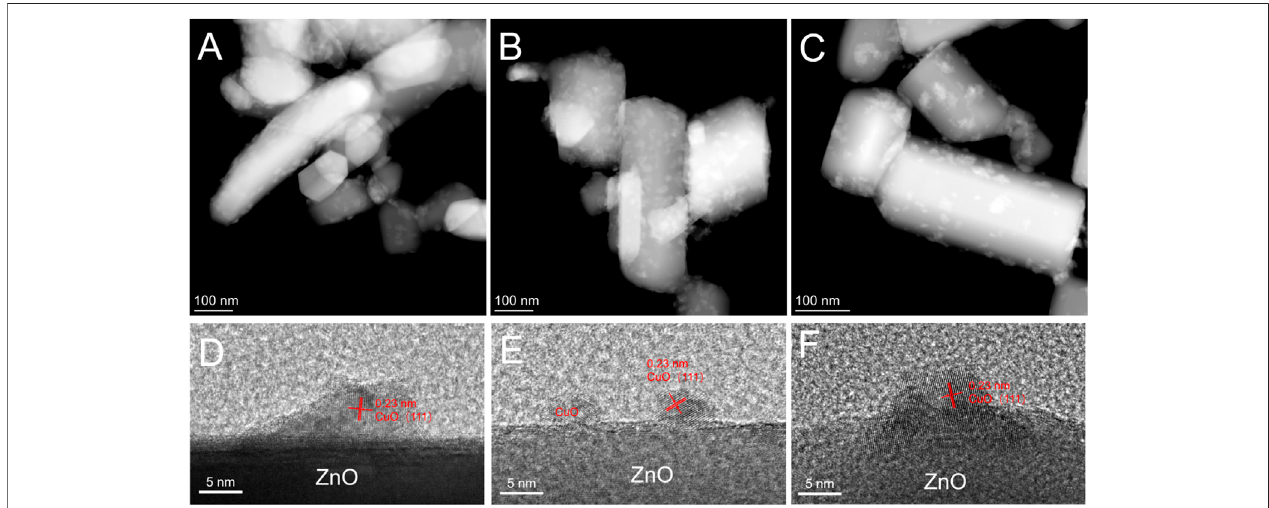
FIGURE 4 | High-angle annular dark- fi eld scanning transmission electron microscopy images of (A) used Cu and (C) usedCu